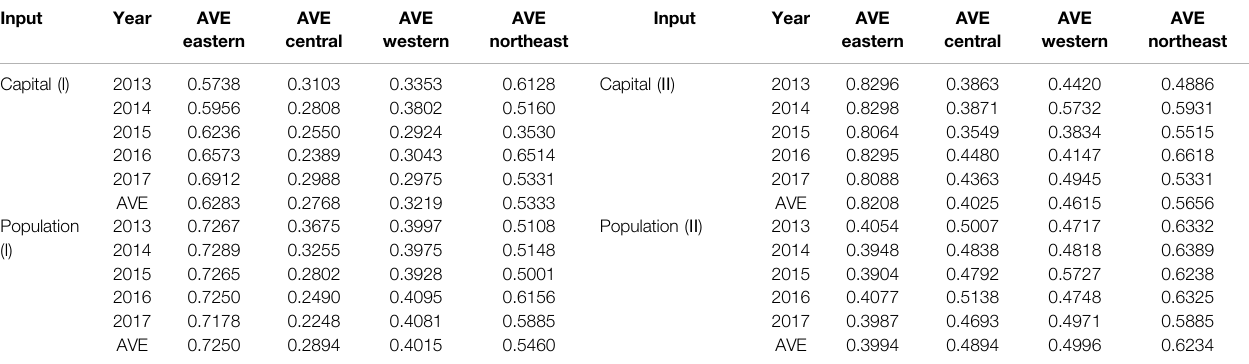
TABLE 4 | Ef fi ciency of capital and population under the in fl uence of regional